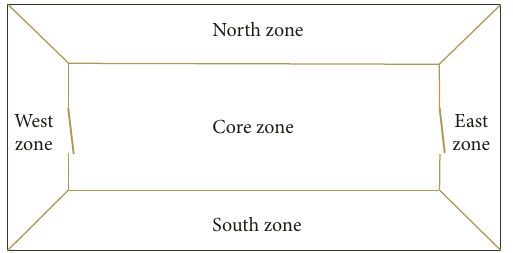
Figure 15: Five-zone office building